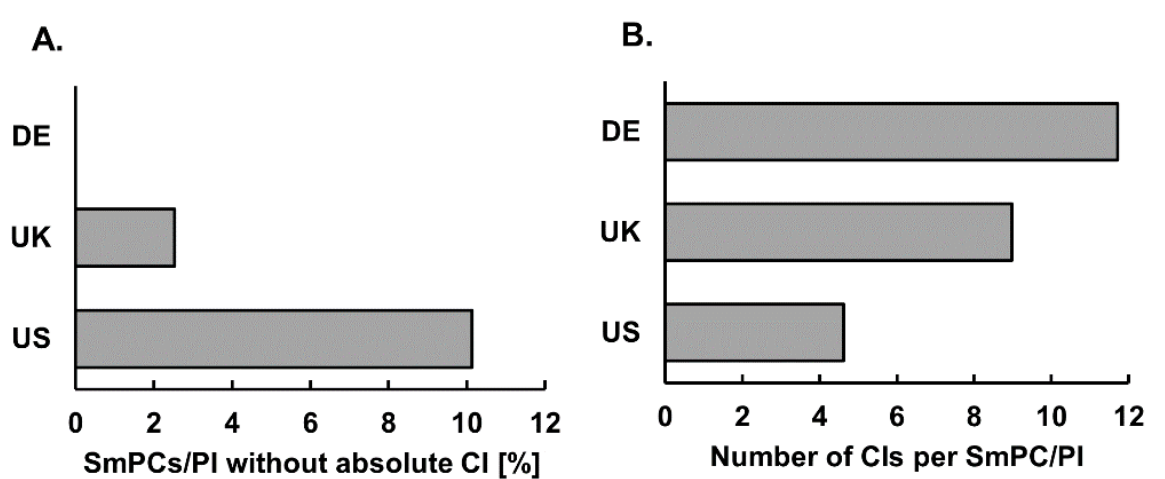
Figure 2. Quantitative analysis of CIs in DE, UK and US SmPCs/PI. ( A ). Percentage of SmPCs/PI among 158 analyzed SmPCs/PI without any absolute CI in Germany, UK and US. ( B ). Average num- ber of absolute CIs per SmPC/PI in German, UK and US PI among 158 analyzed SmPCs/PI. CI: con- traindication, DE: Germany, PI: Prescribing Information, SmPC: Summary of Product Characteris- tics.